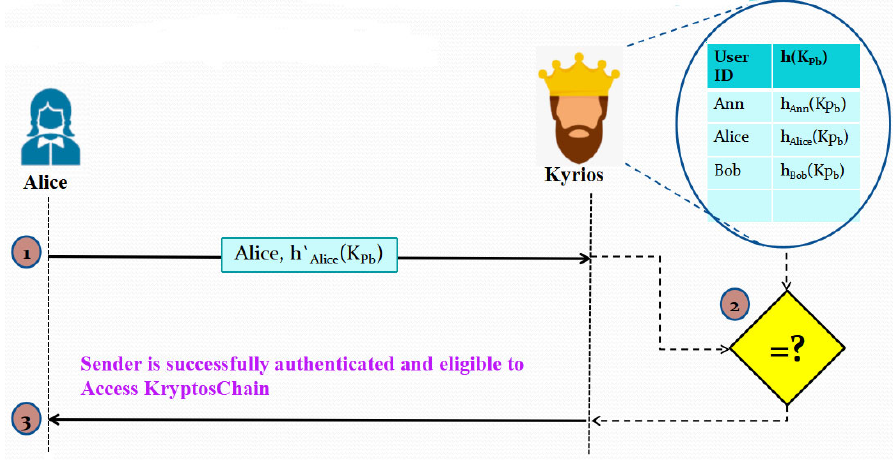
Figure 3. Illustration of Phase 2: Sender Authentication.